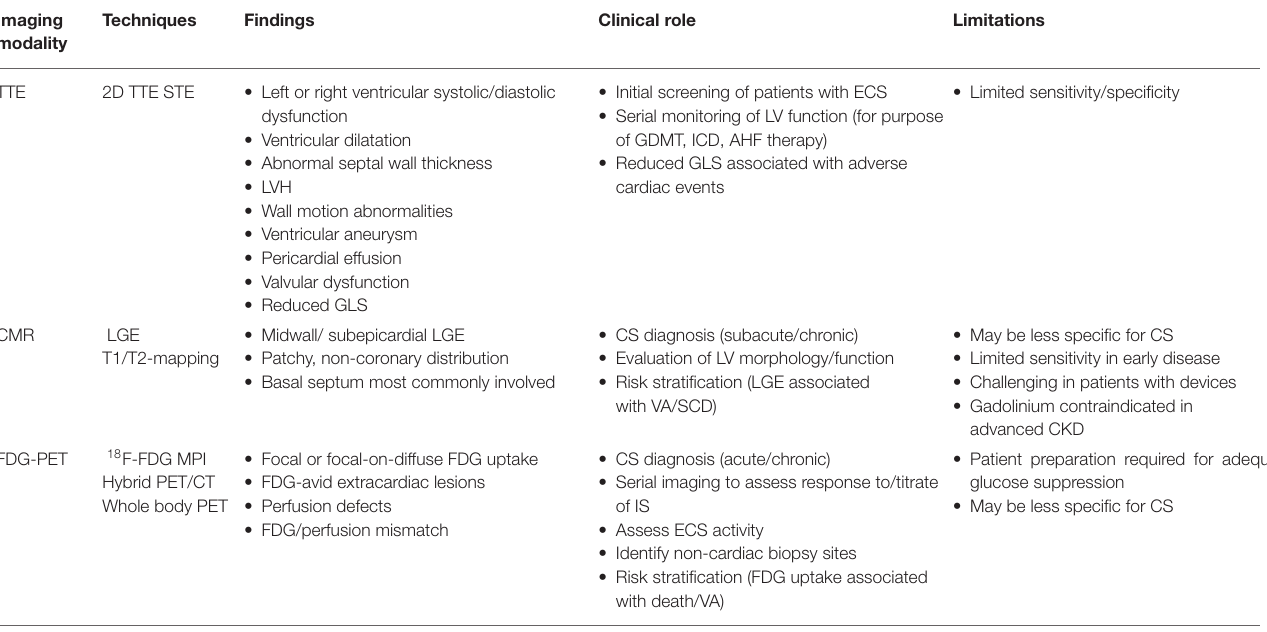
TABLE 1 | Imaging modalities for the diagnosis and management of cardiac sarcoidosis. Imaging